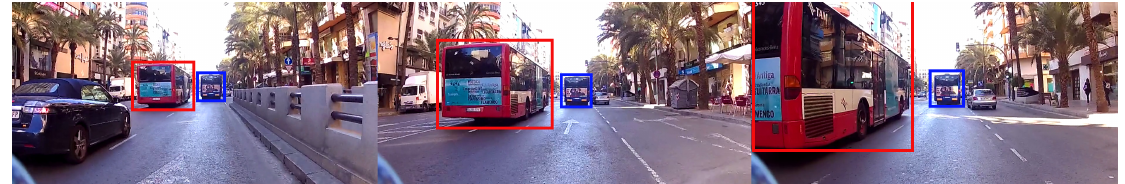
Figure 14. Objects changing size rapidly after a few frames. Red bus vs. blue